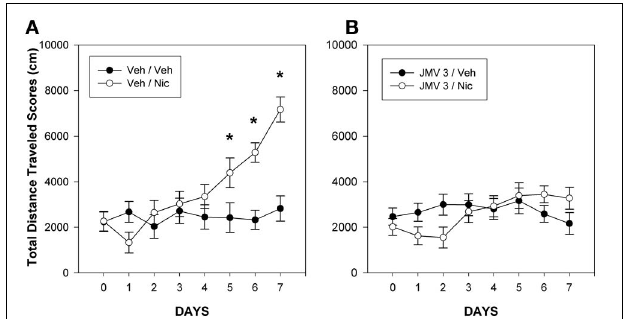
FIGURE 1 | Mean group total changes in total distance traveled scores (cm/45min). On day 0, the rats were injected with Veh at − 5min prior to the 15min baseline period and then again with Veh just prior to the 45min test period. During days 1–7, the rats were injected with either Veh, (panel A ) or 3mg/kg JMV 2959 (JMV 3: panel B ) at − 5min prior to the 15min baseline period and then injected with either vehicle or 0.4mg/kg nicotine (Nic) just prior to the 45min test period on days 1–7. The lines above and below each symbol represent the SEM. Figure reprinted with permission from Regulatory Peptides (Wellman et al., 2011). ∗ p < 0 .